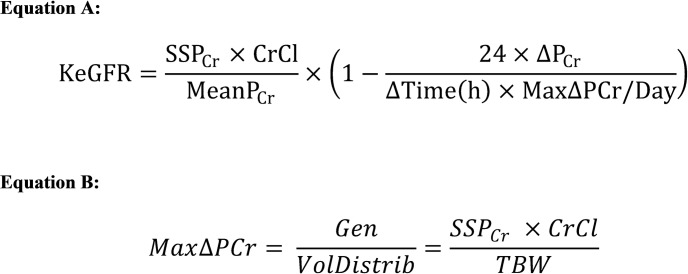
Kinetic eGFR equation as formulated by Chen et al.(Equation A) SSPCr denotes steady state plasma creatinine (in this analysis, serum creatinine at enrollment. CrCl is the estimated glomerular filtration rate calculated using the Cockcroft-Gault or CKD-EPI (unadjusted for body surface area) estimating equation with the SSPCr. Mean PCr is the mean of SCr from that day and SCr from 24 hours prior. ΔPCr denotes the difference between the SCr from that day and SCr from 24 hours prior. Max ΔPCr indicates maximum change in creatinine per day as estimated by equation B. (Equation B) Max ΔPCr is calculated from the rate of creatinine generation divided by the volume of distribution. The total body water was defined as 0.6*baseline weight in kilograms.